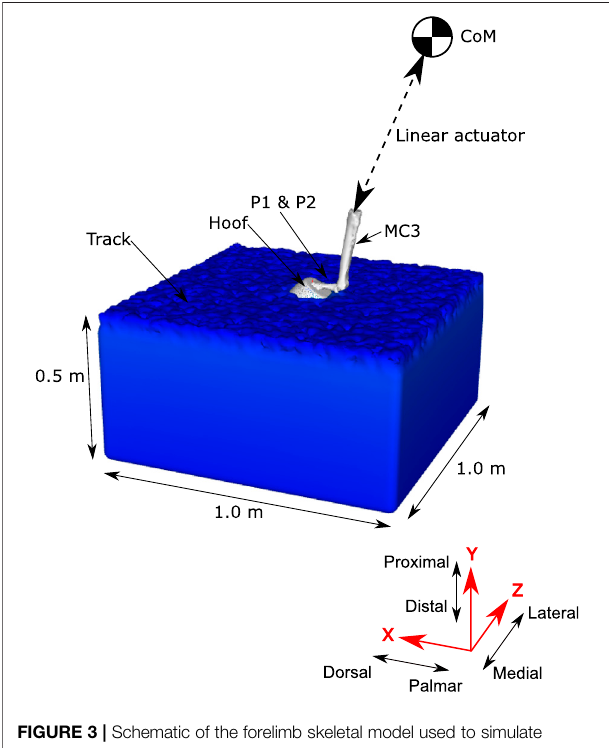
FIGURE 3 | Schematic of the forelimb skeletal model used to simulate hoof-track forces during locomotion. The SPH track model is the same as used for CalibrationoftheTrack ModelMaterialPropertiesUsingDataFromthe Track Testing Experiments section. The forelimbisrepresented bysurface meshesofthedistalbones(forvisualisationpurposes)andtheoutsidesurfaceof the hoof. The position and orientation of the hoof is prescribed from motion capture data, but the vertical position of the hoof is predicted by the simulation.